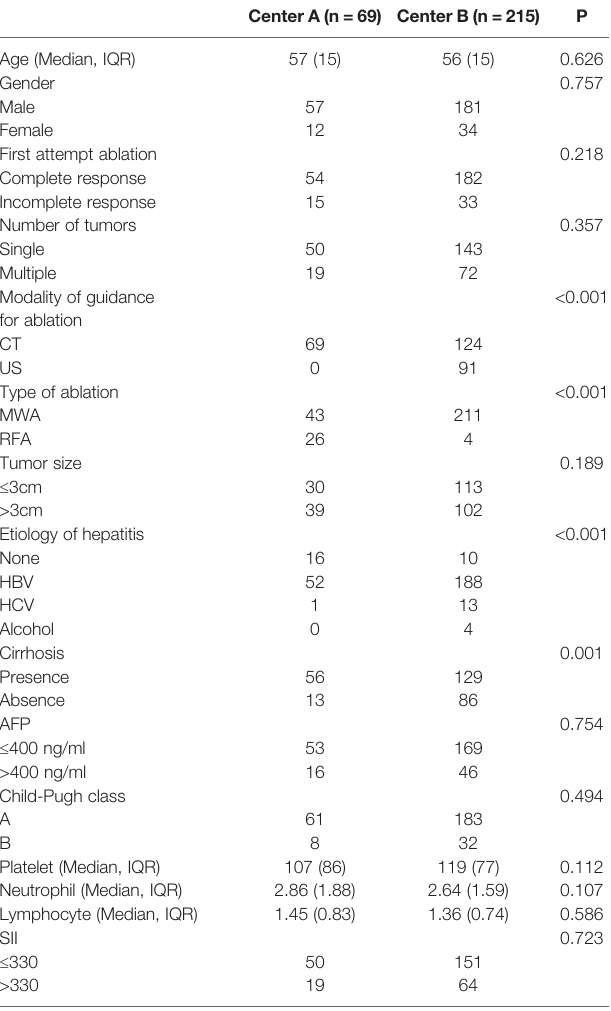
TABLE 1 | The baseline characteristics of patients among the two